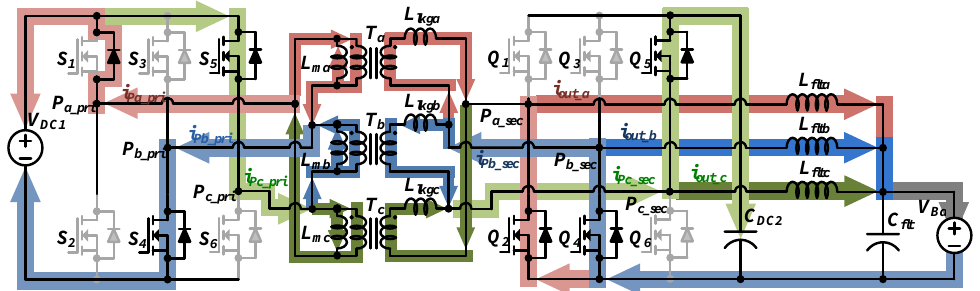
Figure 6. The current flow in Mode 1.